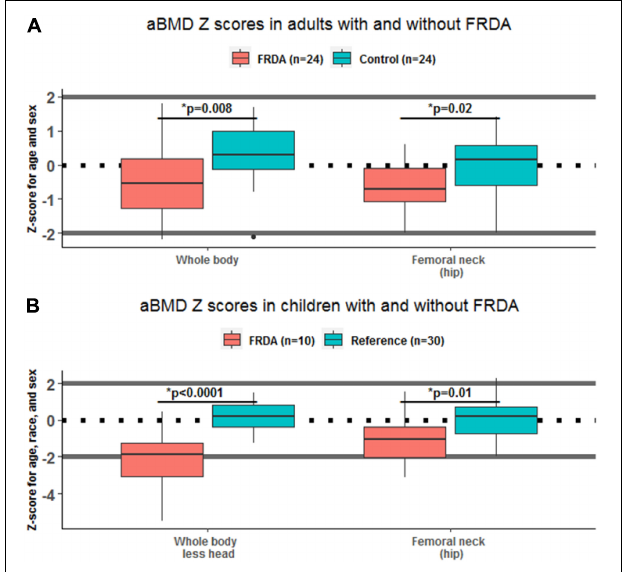
FIGURE 1 | Areal bone mineral density (aBMD) Z-scores in adults and children, with and without Friedreich’s Ataxia (FRDA). Box plots show the difference between skeletal site specific aBMD Z-scores in individuals with FRDA (red) and controls (green), stratified by age. Statistically significant differences between FRDA and healthy controls are indicated above each pair of boxes. Panel (A) shows results in adults ages 18–55 y, and panel (B) shows results in children under 18